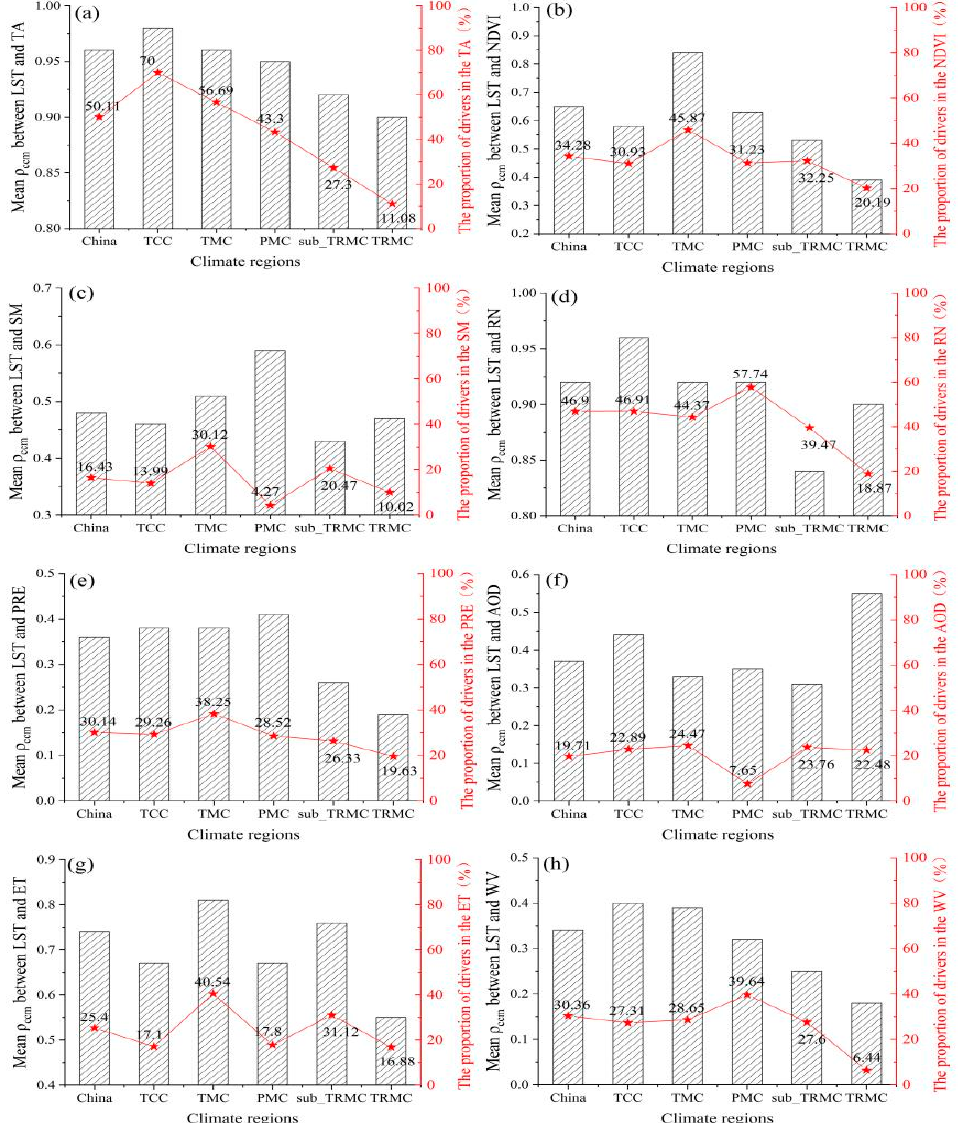
Figure 12. Mean values of ρ ccm between LST and drivers across climate zones and the proportion of drivers in each environmental factor. ( a ) TA ( b ) NDVI ( c ) SM ( d ) RN ( e ) PRE ( f ) AOD ( g ) ET ( h ) WV.